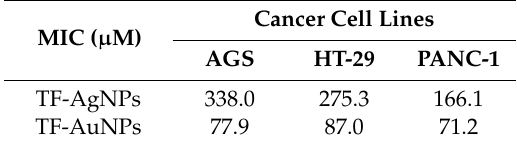
Figure 10. 3-(4,5-dimethylthiazol-2-yl)-2,5-diphenyltetrazolium bromide (MTT) assay on ( A ) human gastric adenocarcinoma cell (AGS), ( B ) human colorectal adenocarcinoma cell (HT-29) and ( C ) human pancreas ductal adenocarcinoma cell (PANC-1) cells. Table 2. MIC of TF-AgNPs and TF-AuNPs on three cancer cell